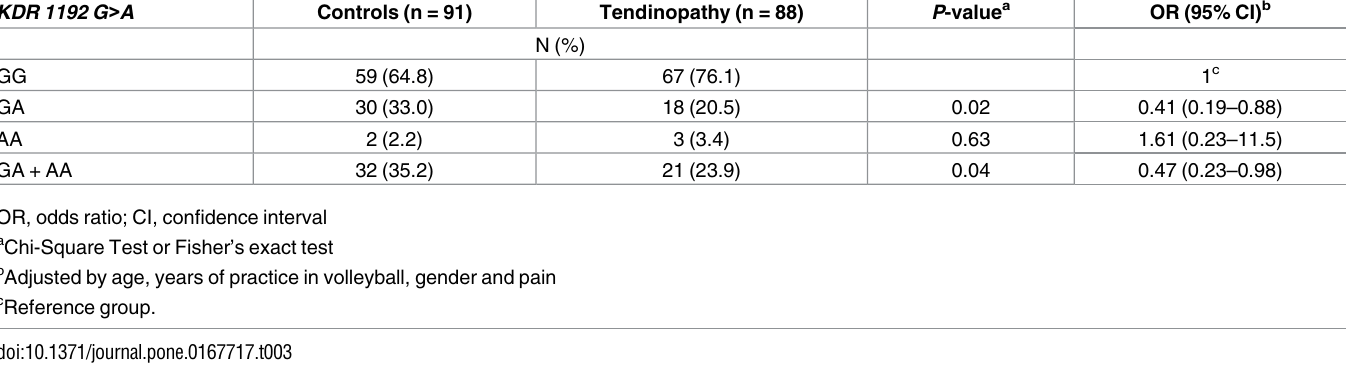
Table 3. Association analysesof the KDR 1192G > A polymorphism in tendinopathy cases compared with athletes without disease. KDR 1192 G >